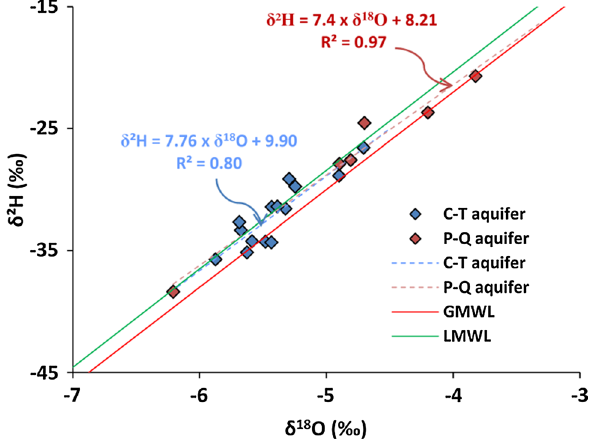
Fig. 10 δ 2 H–δ 18 O stable isotope diagram of the analyzed groundwa- ter samples. C-T = Cenomanian-Turonian, P-Q =